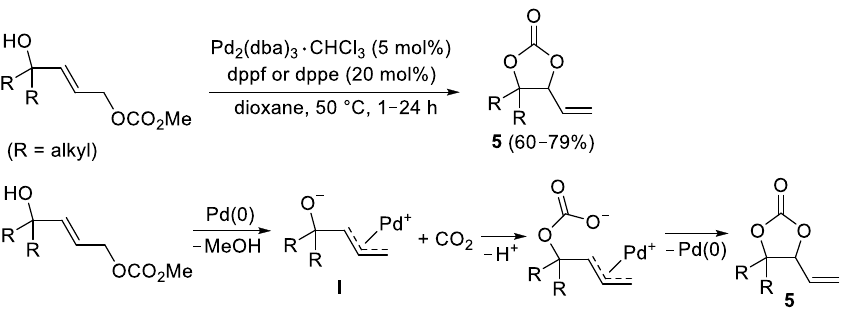
Scheme 6. Synthesis of 4-vinyl-1,3-dioxolan-2-ones 5 from ( E )-4-hydroxybut-2-en-1-yl methyl car-